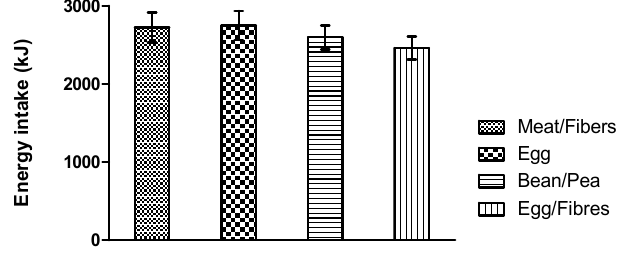
Figure 2. Ad libitum energy intake three hours after the participants received the test meals, analyzed using a mixed linear model including meal as a fixed effect.